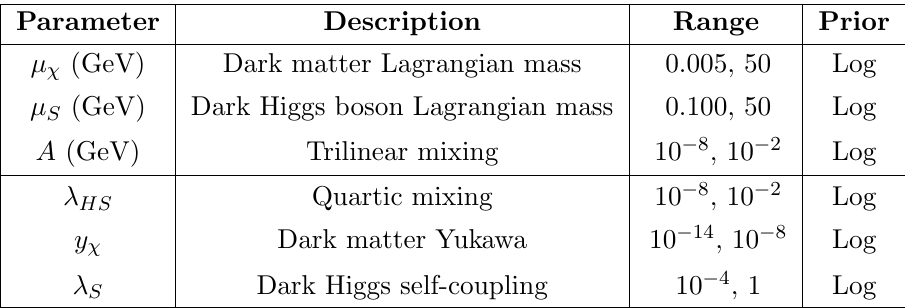
Table 1. Ranges of the parameters of the model analysed in this scan. Dimensionful quantities are given in